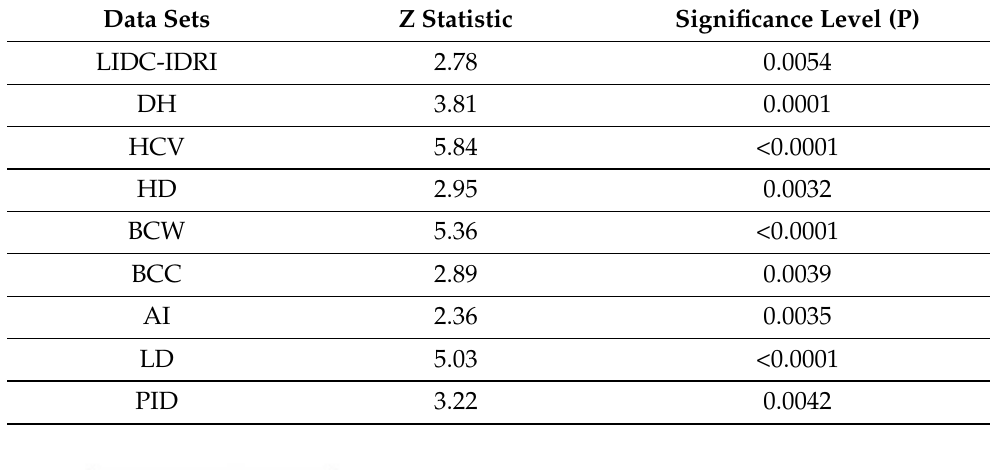
Table 7. AUC significance level between CCG-DLNN and GP-DLNN algorithms.